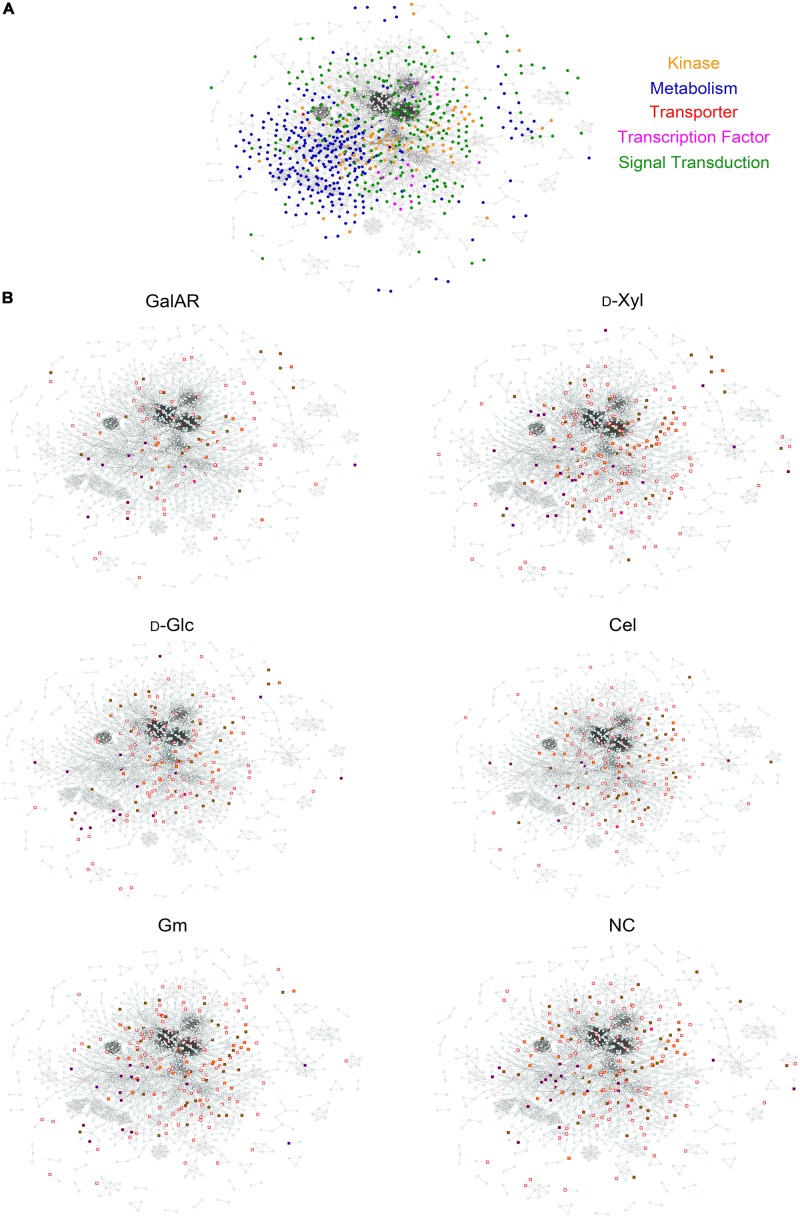
Protein-Protein Interaction network. (A) The PPI network of all proteins identified by proteomics and phospho-proteomics in our experiments. Functional categories related to signaling are color-coded: green, signal transduction; orange, kinases; blue, metabolism; pink, transcription factors; red, transporters. (B) Visualization of proteins in the PPI with specific phospho-peptides (independent of AScores) found in each experimental condition. Squares represent phosphorylated proteins, circles non-phosphorylated proteins. Red border-colored squares represent proteins phosphorylated specifically at the displayed condition and when filled, the proteins belong to one of the functional categories described in panel (A). GalAR (D-GalA + L-Rha), D-Glc (D-Glucose), D-Xyl (D-Xylose), Cel (cellobiose), Gm (Glucomannodextrins), NC (No carbon).